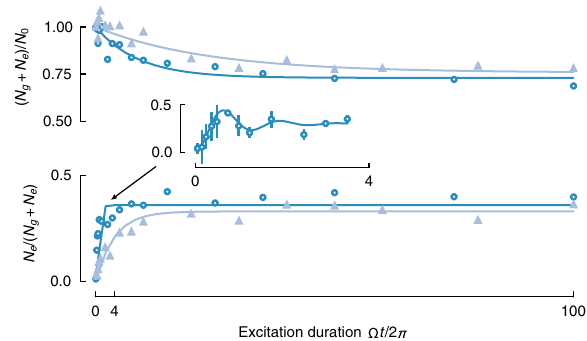
FIG. 9. The clock-excitation dynamics. The total atom number N g + N e normalized to the initial total atom number N 0 (top) and the excited fraction (bottom) as a function of the clock-excitation duration. The inset is an enlarged portion of the initial excita- tion dynamics, fitted with an exponentially decaying sine. The measurements are repeated with an external magnetic field at approximately 45 G (triangles) and approximately 225 G (cir- cles). The data are fitted with exponential functions as a guide to the